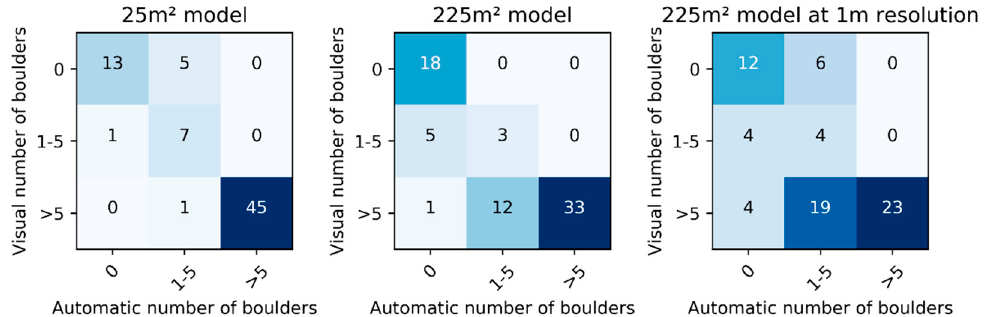
Figure 8. Confusion matrix of boulder densities determined by the different models vs. the visually interpreted mosaic. Parameters derived from the confusion matrix are given in Table 1. Table 1. Accuracy (ACC), precision (P), and recall (R) of the boulder density confusion matrix.